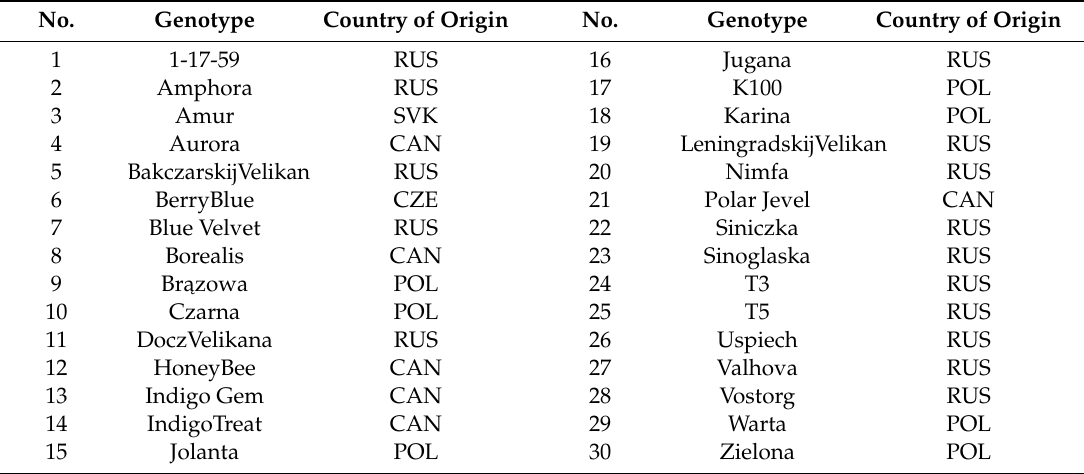
Table 1. List of genotypes